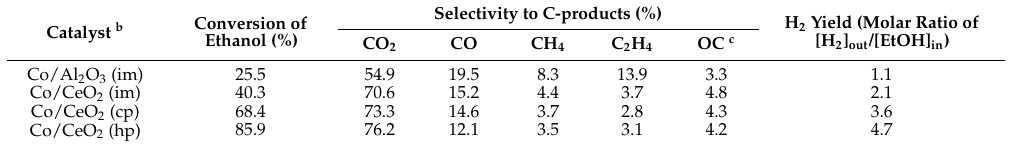
Table 2. Reaction results over various catalysts for the steam reforming of ethanol at 673 K a . Catalyst b